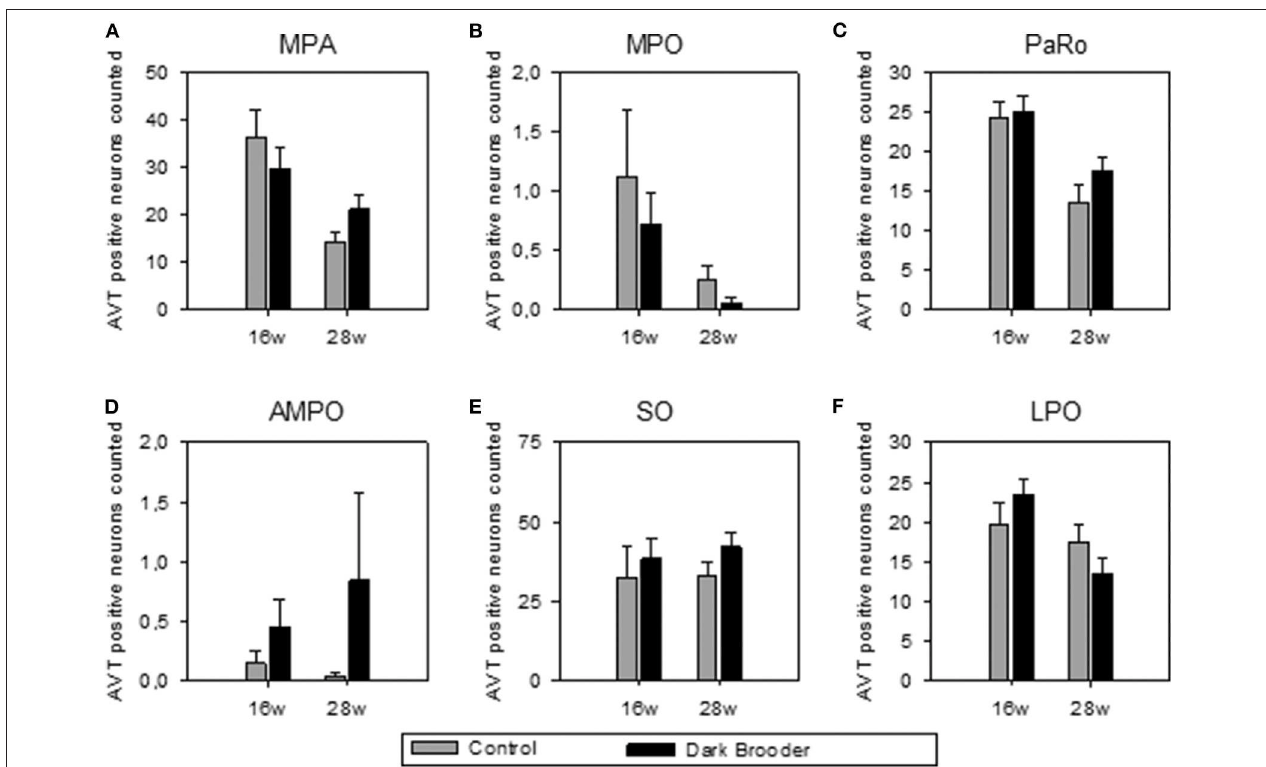
FIGURE 1 | Number of AVT-positive neurons counted per region of interest (mean ± SEM). (A) MPA, medial preoptic area; (B) MPO, medial preoptic nucleus; (C) PaRO, paraventricular nucleus, rostral part (prepeduncular hypothalamus); (D) AMPO, anteromedial preoptic nucleus; (E) SO, supraoptic nucleus; (F) LPO, lateral preoptic area. 16w, 16 weeks of age; 28w, 28 weeks of age.